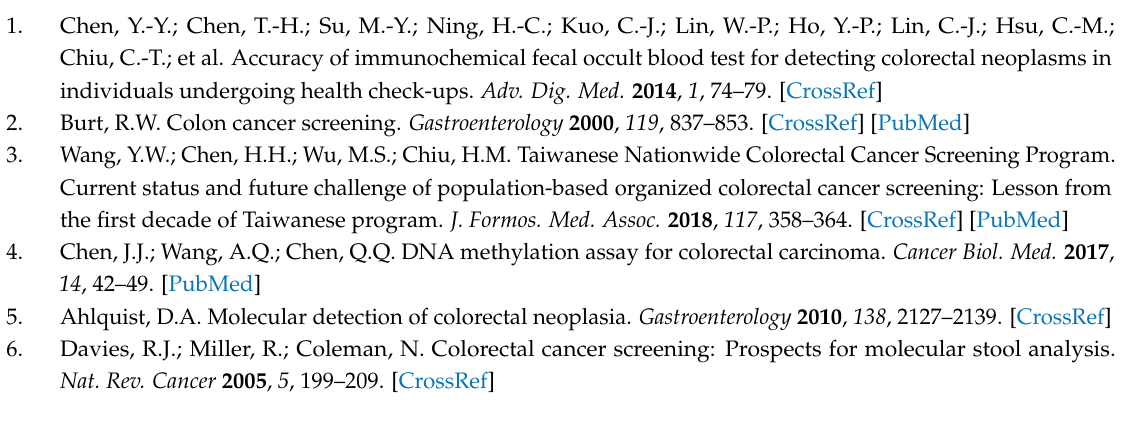
Figure S1: Accuracy check of MassARRAY stool DNA panel, performed using diluted DNA from tissues with known mutations; Table S1: A. PCR primer sequences and amplicon sizes for the CGMH stool DNA panel. B. Extension primer sequences and their distributions in the four wells; Table S2: FIT value and variants detected using the stool DNA panel in 101 participants of cohort 2; Table S3: Proportion of human DNA in the tool DNA of cohort